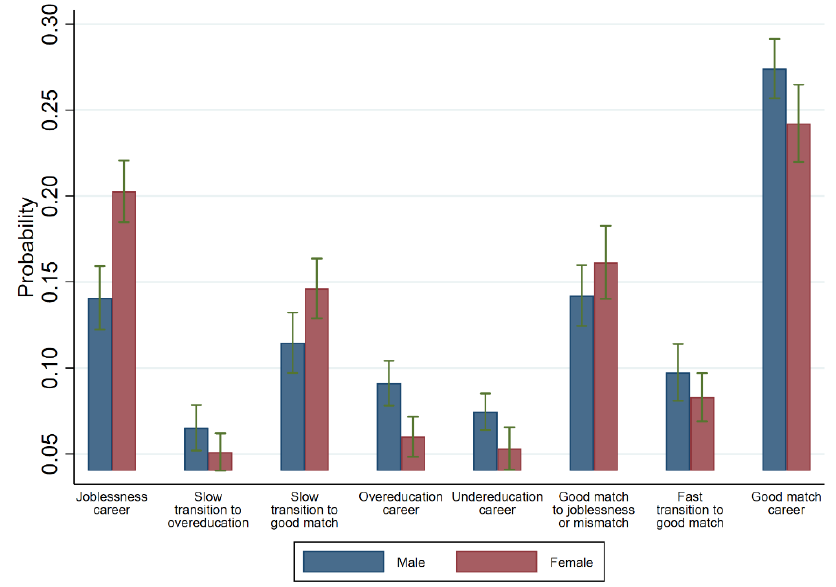
Figure 3. Predicted probabilities by educational mismatch career trajectory and sex. Estimated from multinomial logistic regression model in Table A3 in the Appendix A; 95% confidence intervals are shown.